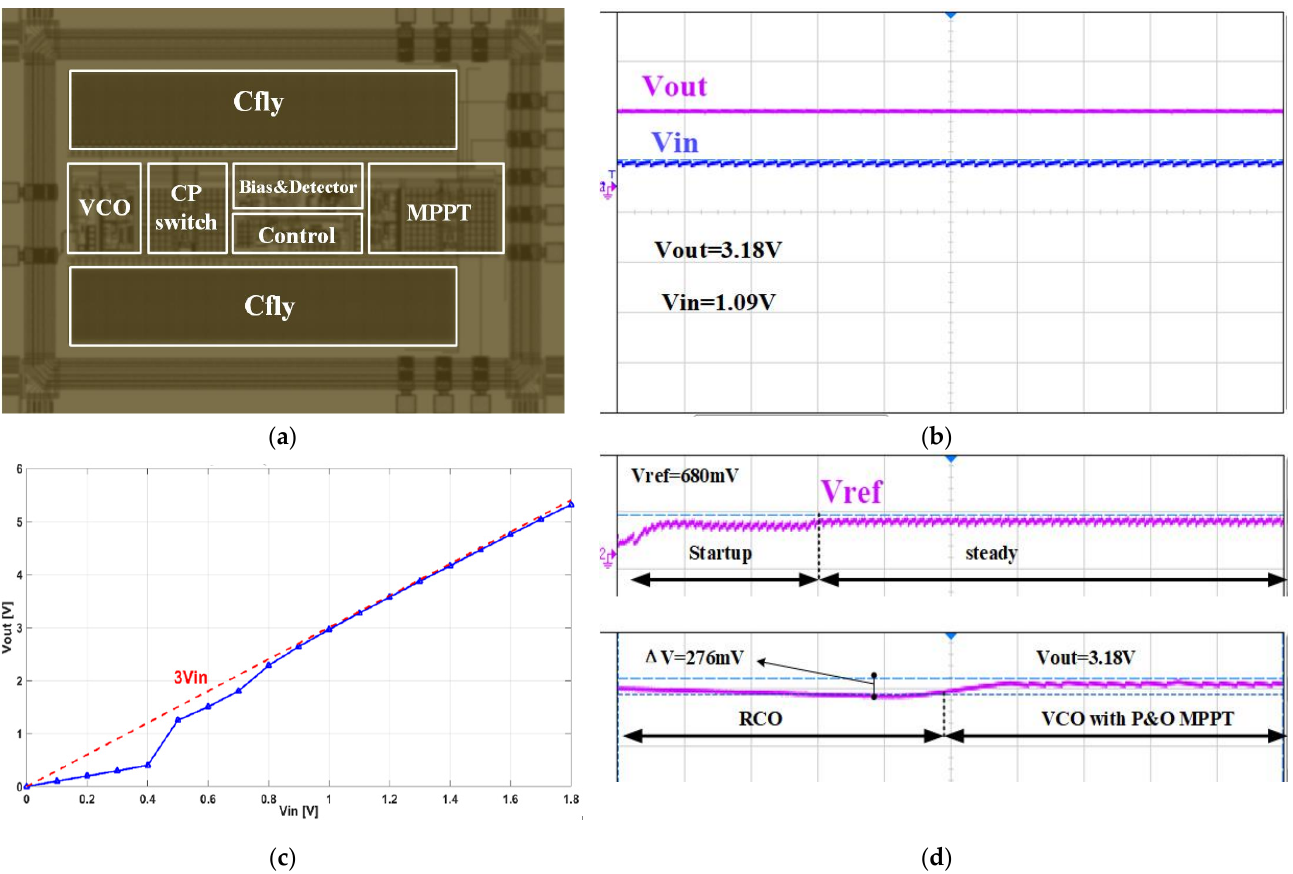
Figure 15. ( a ) The micro-photograph of VBC IC; ( b ) Measured waveform of output and input voltage; ( c ) Transfer characteristic of VBC; ( d ) Measured waveform of V ref and the output voltage in the switching process.